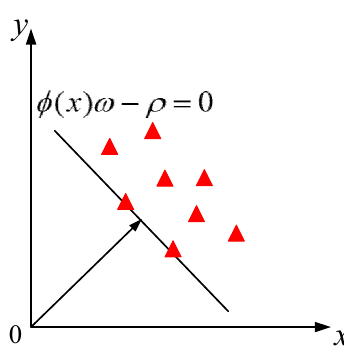
Figure 8. The classification principle of one-class support vector machines (OCSVM).